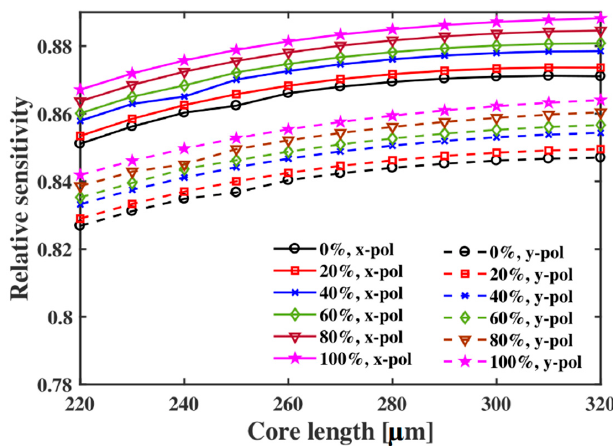
Figure 3. Relative sensitivity of the proposed oil adulteration sensor at different core length condition for both x and y -polarization modes at f = 2.8 THz. Fibers 2020 , 8 , x FOR PEER REVIEW